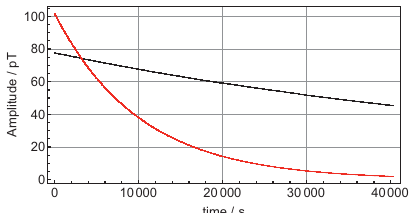
Figure 4. Free induction decay (run number 4) of 3 He (black) and 129 Xe (red). The error bars are so small and the points are so dense that it looks like continuous